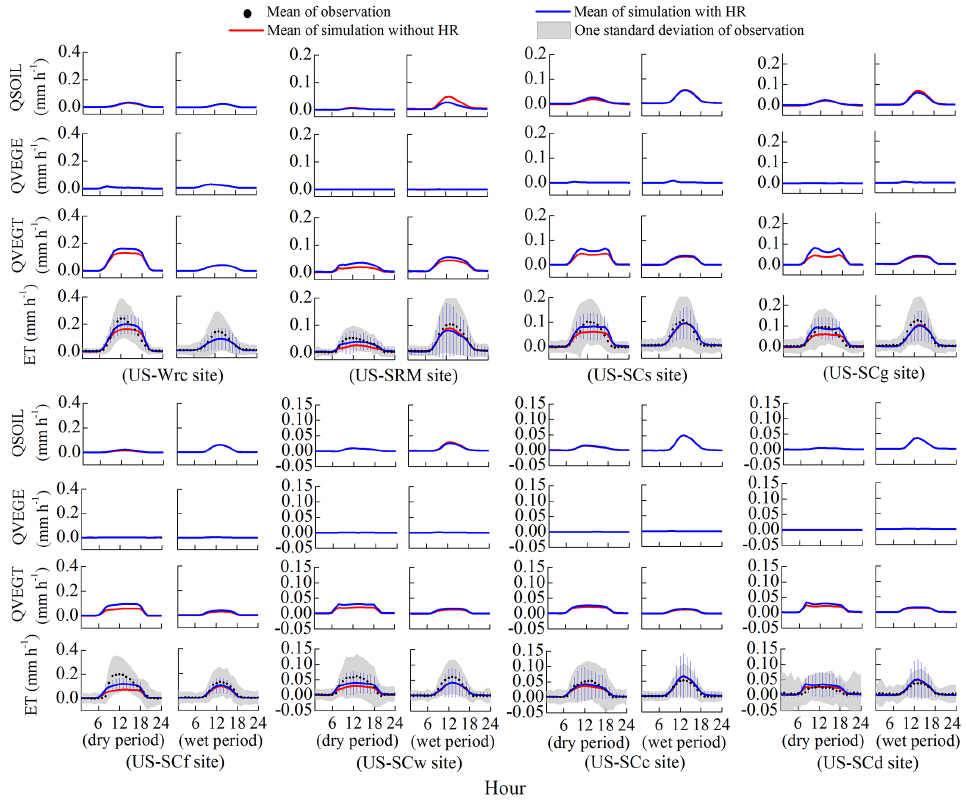
Figure 7. Observed and simulated hourly ET and its components at the eight study sites. “QSOIL” is ground evaporation, “QVEGE” is canopy evaporation, and “QVEGT” is transpiration. “Observation” represents observed ET. “Dry period” and “wet period” represent average values over dry season and wet season (defined in Table 6) for all simulation years, respectively. The thin vertical lines represent 1 standard deviation of simulation with